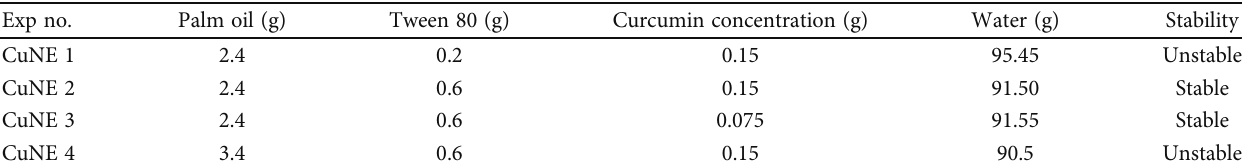
Table 6: Experimental setup for curcumin